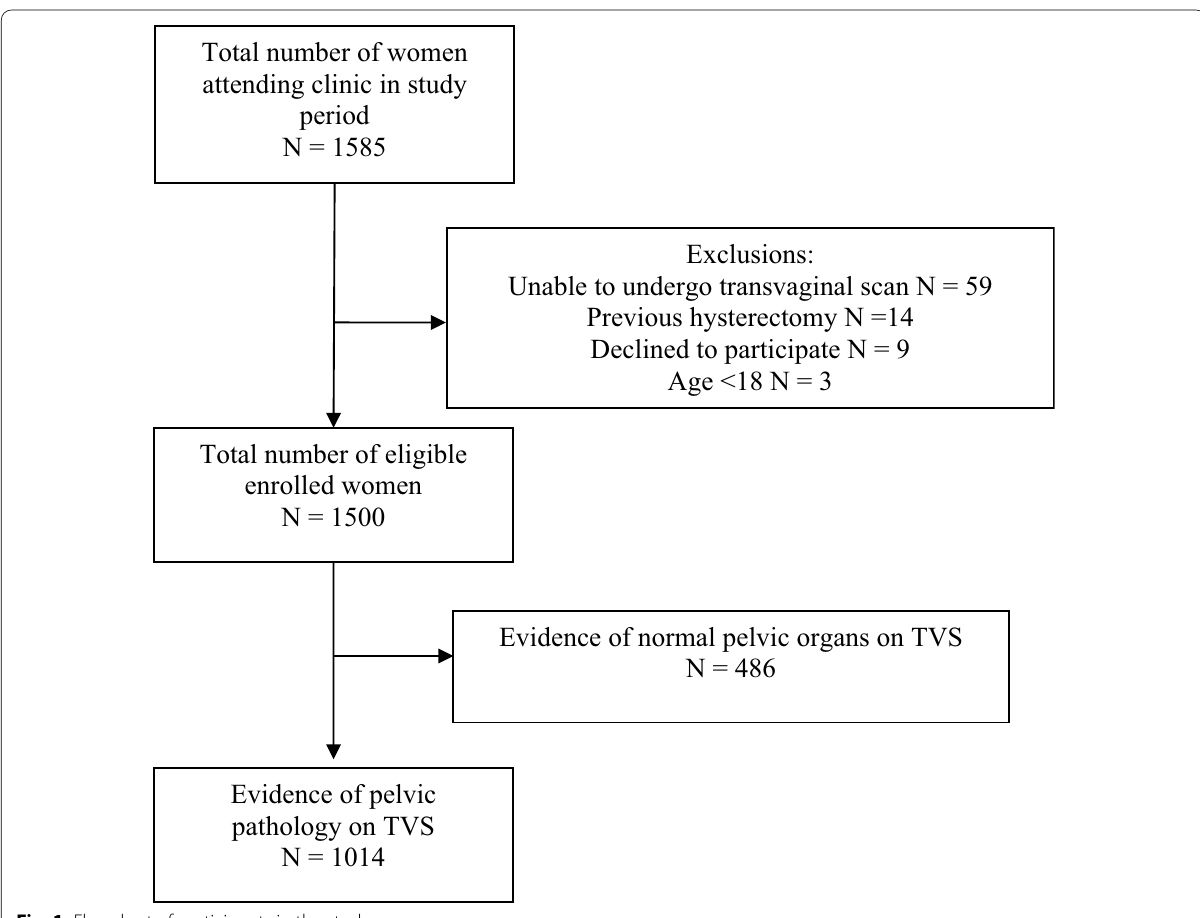
Fig. 1 Flowchart of participants in the study